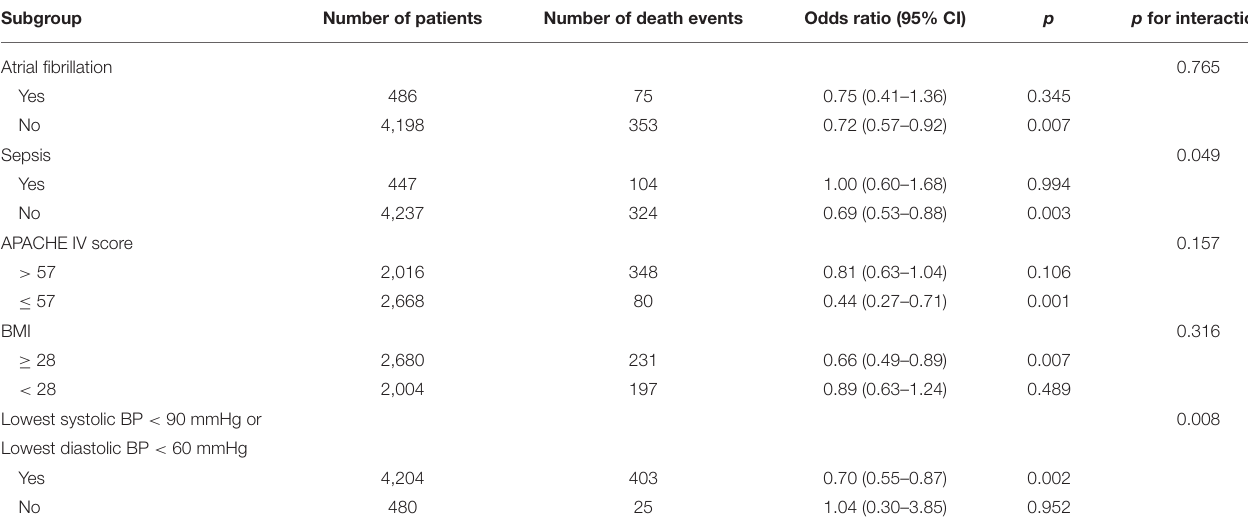
TABLE 2 | Sensitivity analyses of the association between IBP measurement and in-hospital mortality in the PSM cohort.